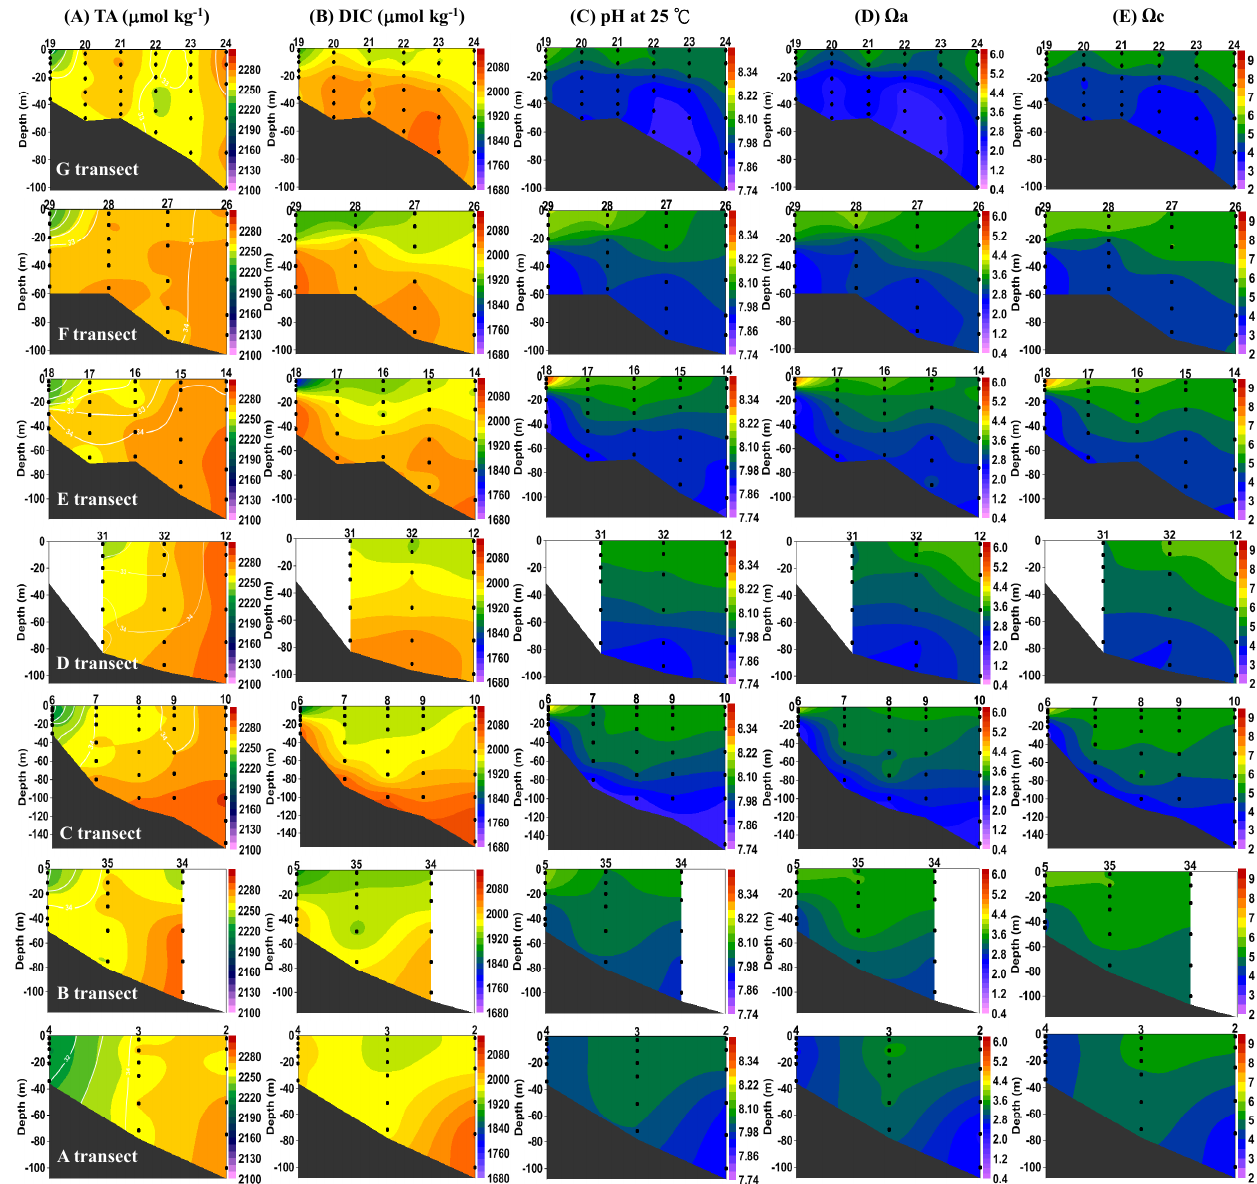
Fig. 4. Vertical distributions of TA, DIC, pH at 25 ◦ C, (cid:127) c and (cid:127) a along the A to G transects in the East China Sea in spring 2009. Superim- posed white lines on TA distributions are